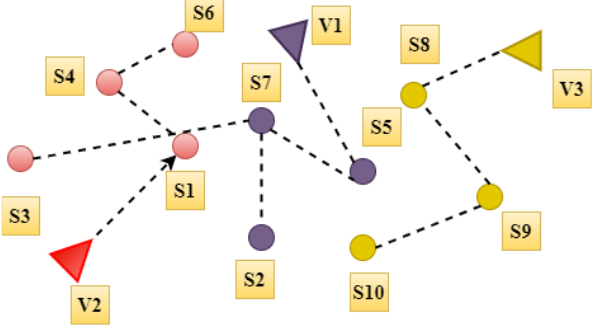
Figure 4. UAV Node Operation.